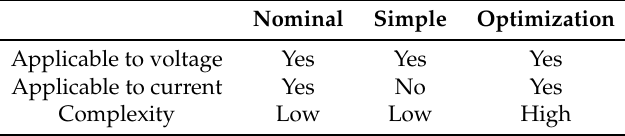
Table 6. Qualitative comparative of the correction